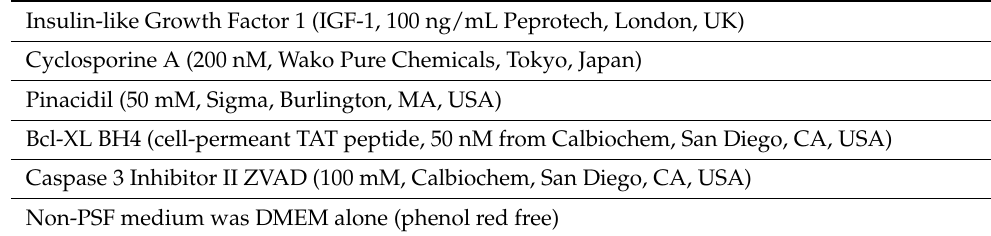
Table 2. Pro-Survival Factors (PSF) used in this